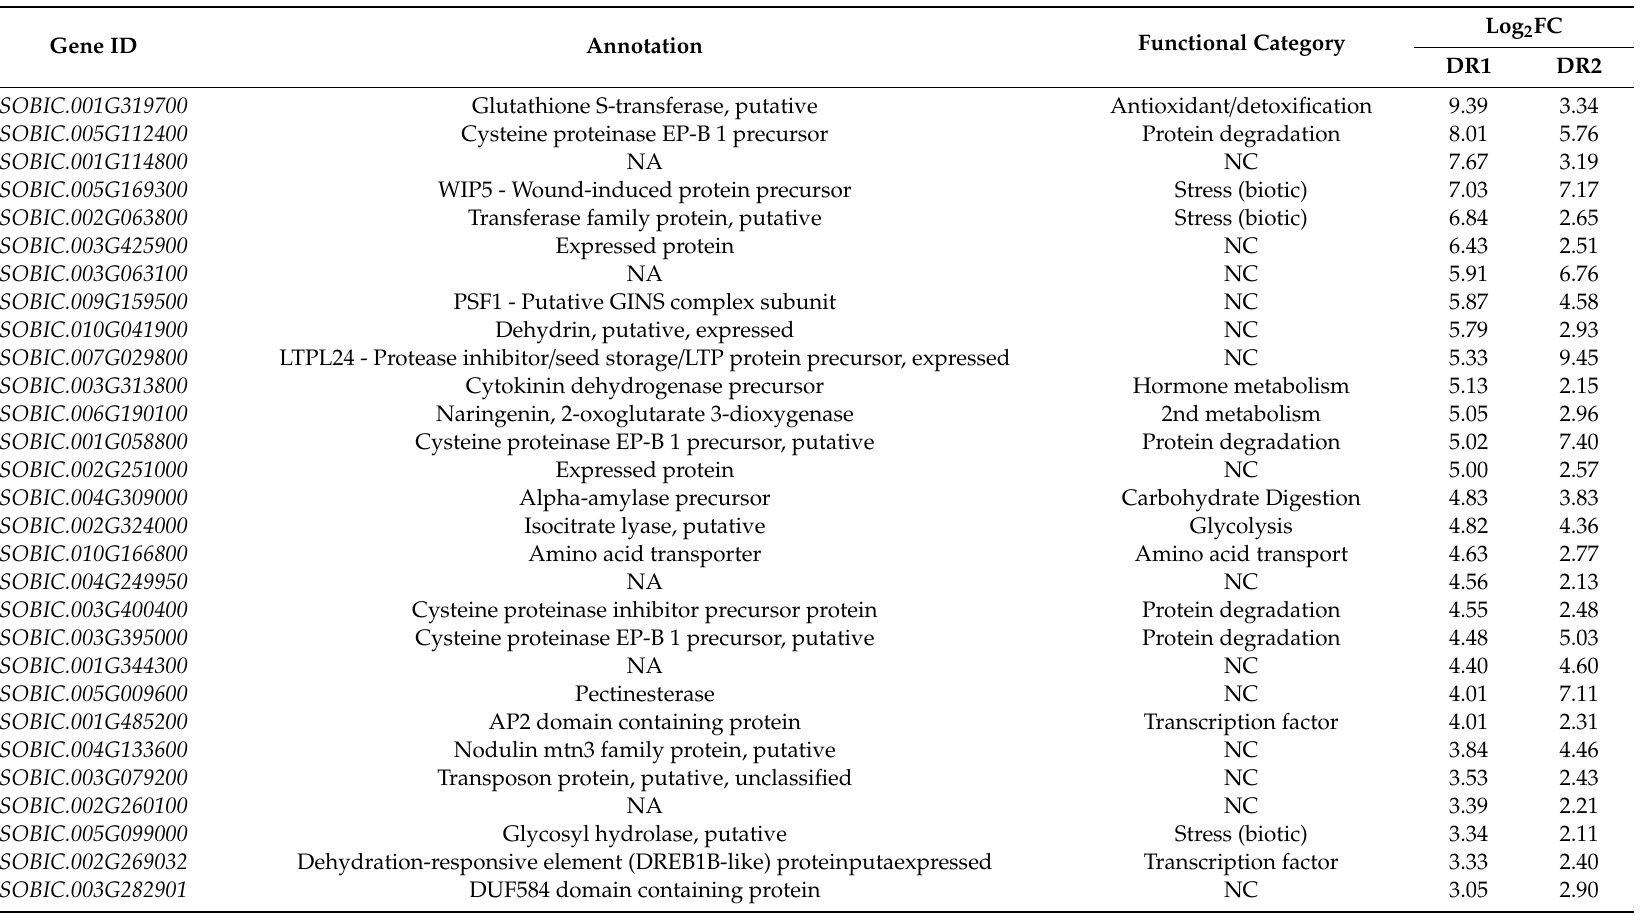
Table 2. Genes ID, annotation, functional category and Log 2 FC of DE genes unique to drought-resistant genotypes (DR1&DR2) at 1h PEG post-treatment. NA means not annotated, NC means not categorized. The functional category was extracted from MapMan analysis using the list of DE genes that show Log 2 FC ≥ 2 or ≤ − 2 and q -value < 0.05. Down-regulated genes are indicated in